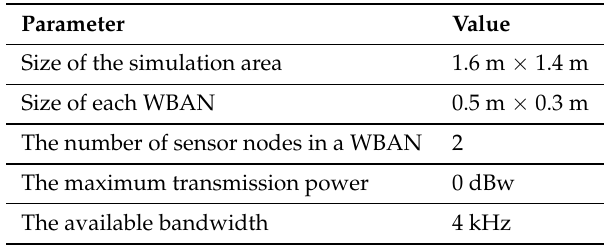
Table 2. Simulation